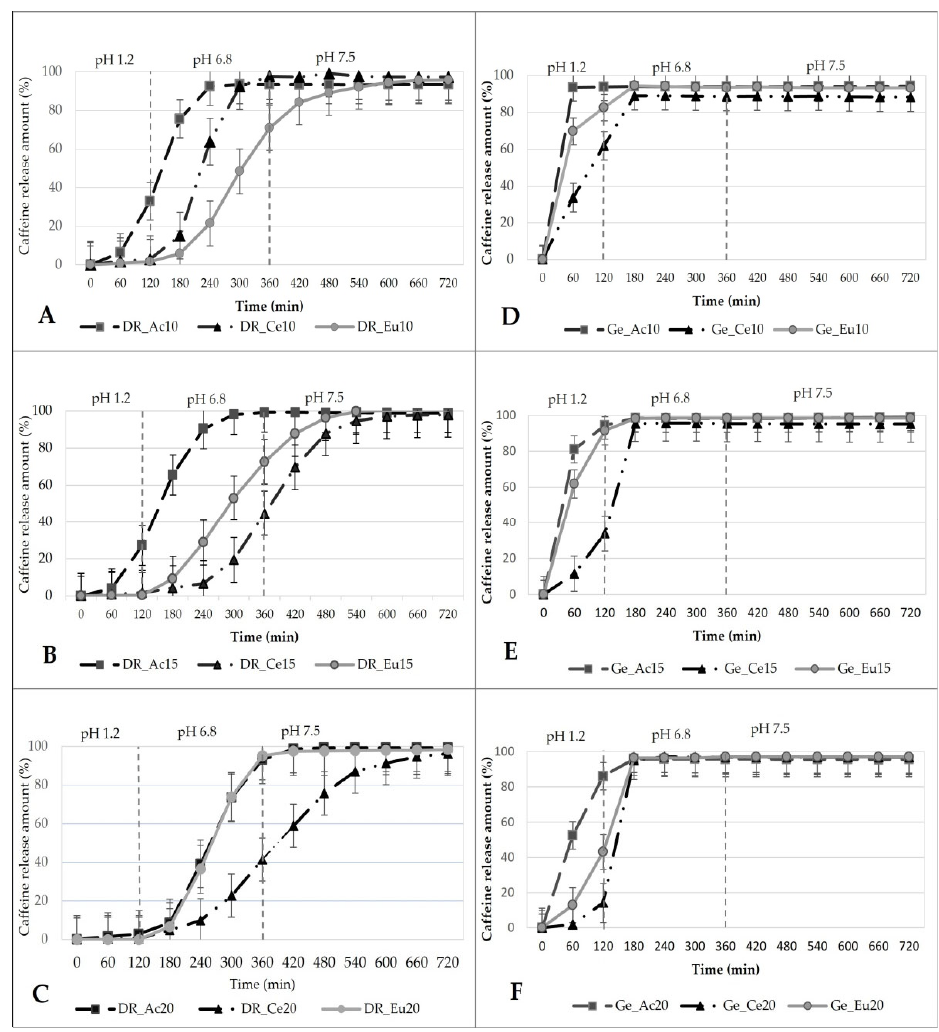
Figure 6. In vitro dissolution profiles of the enteric ‐ coated capsules under three changing conditions (pH 1.2; pH 6.8; pH 7.5); ( A ) DR_samples with 10.0% polymer coatings, ( B ) DR_samples with 15.0% polymer coatings, ( C ) DR_samples with 20.0% polymer coatings, ( D ) Ge_samples with 10.0% polymer coatings, ( E ) Ge_samples with 15.0% polymer coatings, ( F ) Ge_samples with 20.0% polymer coatings. As the concentration of polymer dispersion used for coating increases, the total dis ‐ solution time within the polymer dispersion type (Cellacefate) also increases, namely: DR_Ce10 released 82.06 ± 5.58% API in 270 min; DR_Ce15 in 435 min 75.33 ± 15.54% API; DR_Ce20 in 495 min 78.86 ± 20.92% API. The dissolution profiles of the Cellacefate ‐ based samples are affected by the better continuous increase of the polymer coating, which is related to its increasing concentration in the coating dispersion. A possible explanation is the better cohesion and compactness of Cellacefate coatings compared to other polymeric materials based on cellulosic, methacrylic, or vinyl derivates [47].